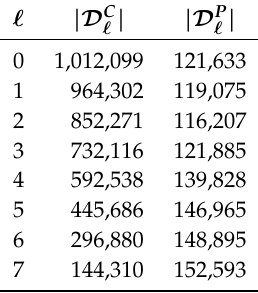
Table 8. Number of observations in the calibration and the prediction set of each lag in the claims portfolio observed at time I =